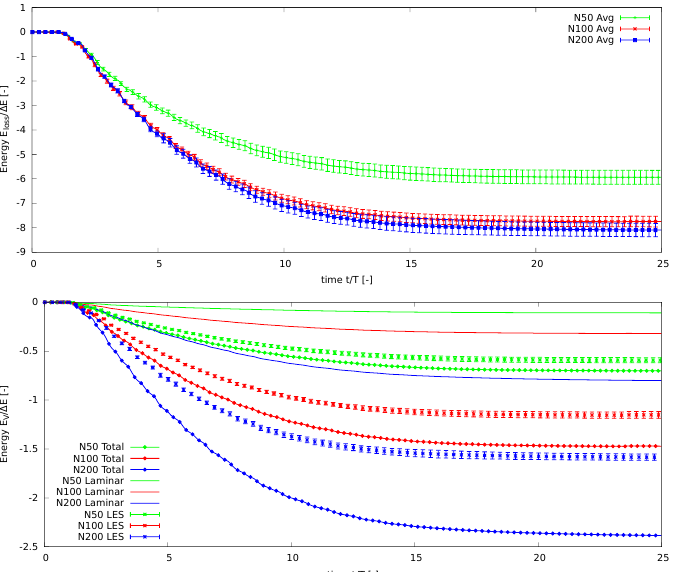
Figure 26. Water average energy dissipation components. The ( top ) shows the impact loss and the ( bottom ) viscous dissipation.